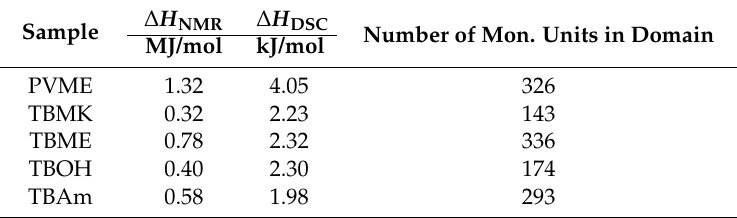
Table 2. Thermodynamic parameters determined by NMR and DSC and the number of monomer units in the domain for mixtures of 5 wt % PVME.